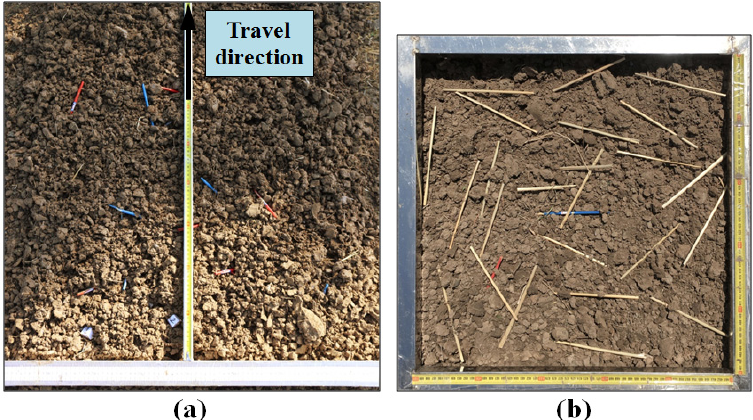
Figure 4. ( a ) Displacement measurement method, ( b ) Sampling to obtain straw burial